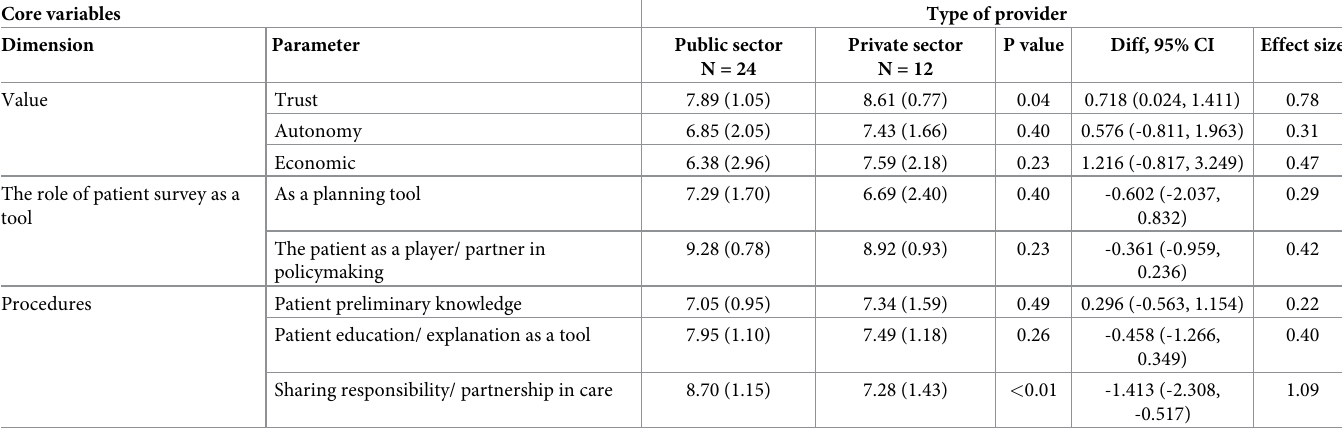
Table 1. Survey core variables by type of provider and role/position